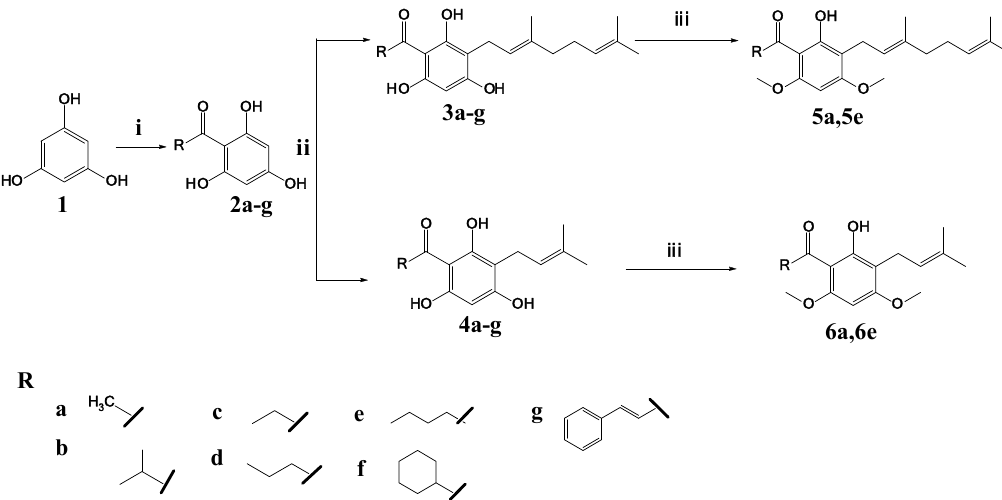
Scheme 1. Reagents and conditions: ( i ) acyl chloride, anhydrous aluminum chloride,